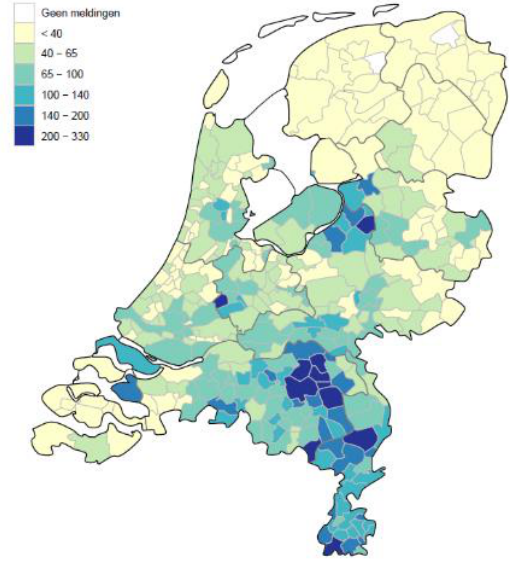
Figure 1. Hospitalized patients with COVID-19 per 100,000 inhabitants per municipality, 11 May 2020 (Dutch National Institute for Public Health and the Environment, RIVM).